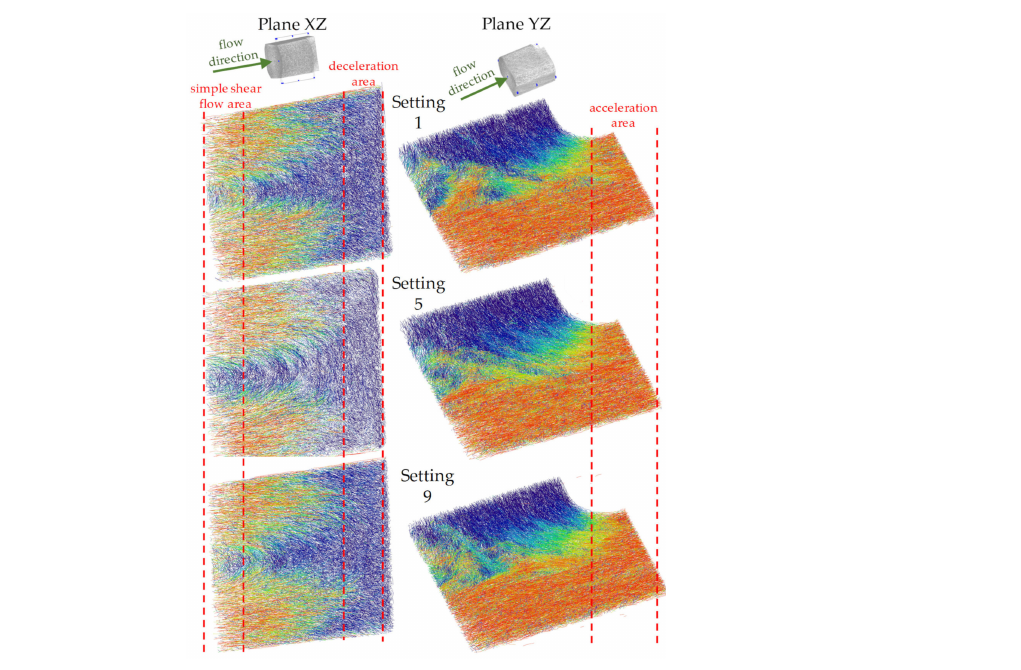
Figure 7. Qualitative comparison of fiber orientations from µ CT analysis in the XZ- and YZ-plane of region 2 after specimen manufacturing with setting 1, 5, and